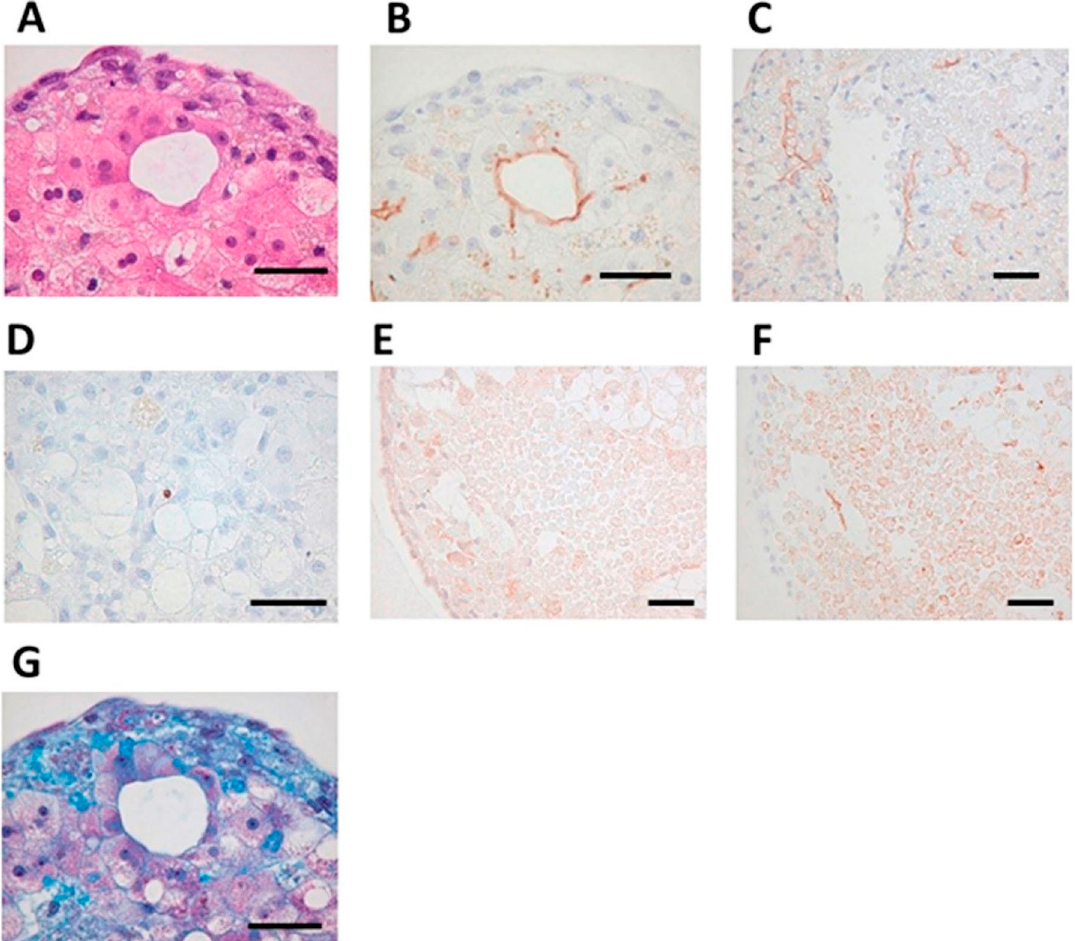
Figure 8. Self-organization in bio-printed human liver tissues. ( A ) Hematoxylin and eosin stain (HE) staining shows structure of bio-printed liver tissue on day 50. ( B ) Immunostaining with the MRP2 antibody detected bile acid transporters (day 50). ( C ) Immunostaining with, cluster of differentiation 31 (CD31) antibody detected blood vessel-like and sinusoid-like structures (day 14). ( D ) Terminal deoxynucleotidyl transferase dUTP nick end labeling (TUNEL) staining detected little apoptosis (day 60). ( E ) Immunostaining with the OAT2/8 antibody detected drug uptake transporters (day 44). ( F ) Immunostaining with MRP2 antibody showed tissue distribution (day 44). ( G ) Masson's trichrome staining shows collagen accumulation (day 50). Black bars represent 50 μ m [82].